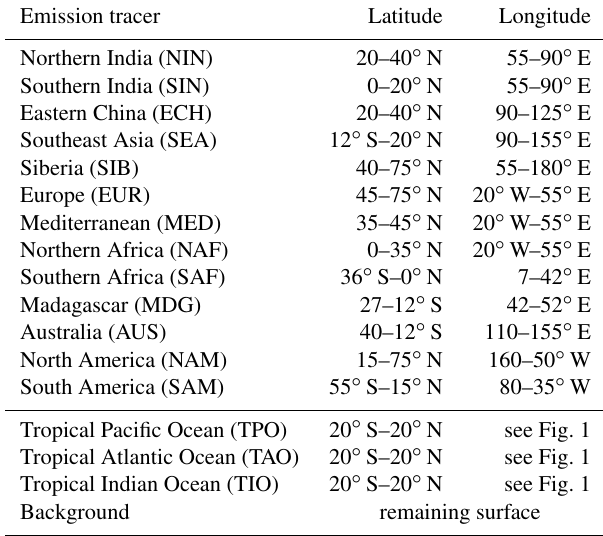
Table 1. Latitude and longitude range of artificial boundary layer sources in the CLaMS model, also referred to as “emission trac- ers”. The geographical position of each emission tracer is shown in Fig. 1. Emission tracer Latitude